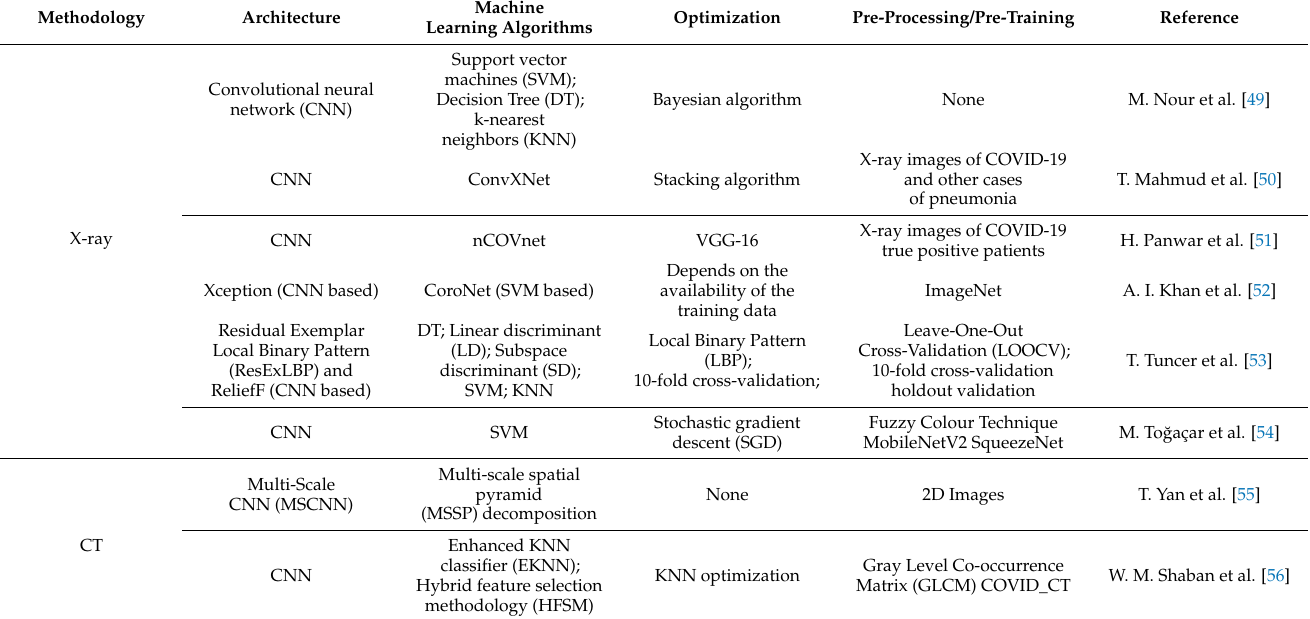
Table 2. Methods reported in the literature for COVID-19 detection through image